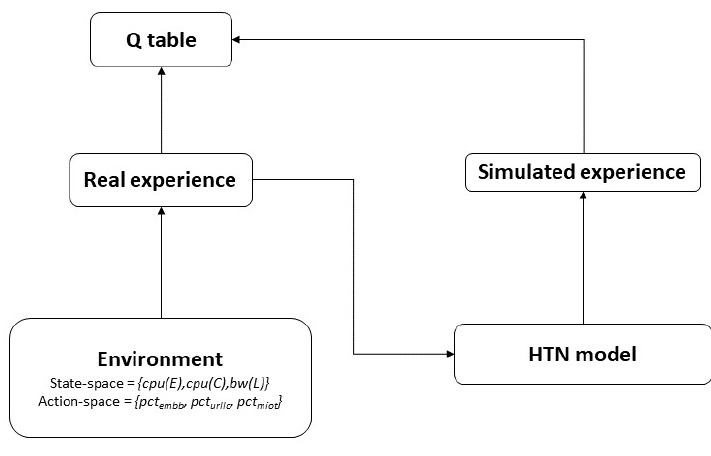
Figure 4. Dyna framework